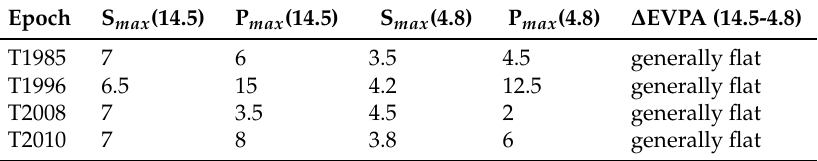
Table 4. Simulated emission properties during modeled